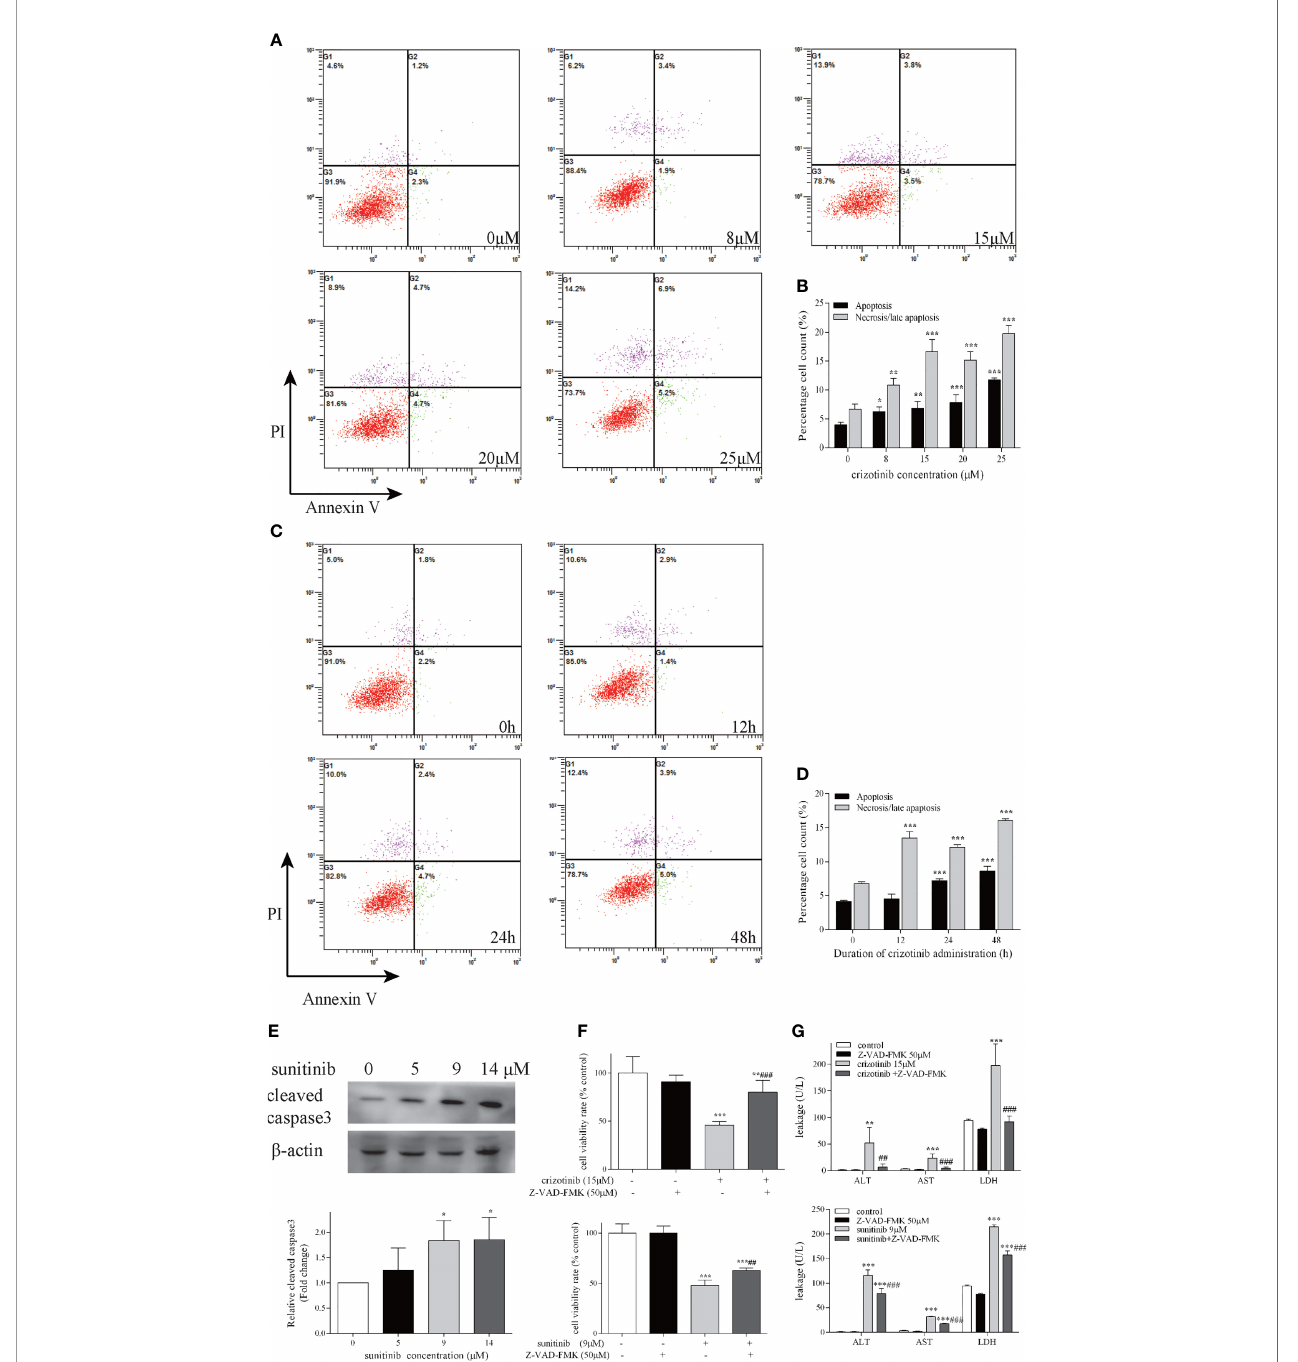
FIGURE 3 | Crizotinib and sunitinib induced apoptosis in HepG2 cells. Following treatment of cells with increasing doses of crizotinib for 24 h (A) and increasing administration time of crizotinib 15 µM (C) , cell apoptosis was measured by Annexin V − FITC/PI double staining assay. In the fl ow cytometry plot, live, early apoptotic, late apoptotic and necrotic cells were shown in the lower left, lower right, upper right and upper left quadrants, respectively. (B) Quanti fi cation of experiments shown in (A) . (D) Quanti fi cation of experiments shown in (C) . (E) Western blot analysis for the level of cleaved caspase 3 after sunitinib exposure for 24 h (n=3). (F) The cell survival rate for HepG2 cells after treatment with crizotinib or sunitinib with or without Z-VAD-FMK. Cell viability was measured by the MTT assay, and (G) The levels of ALT, AST, and LDH in the supernatant of HepG2 cells treated with crizotinib or sunitinib with or without Z-VAD-FMK (n=3). In these experiments, cells were pretreated with Z-VAD-FMK 50 m M for 24 h before crizotinib (15 m M) or sunitinib (9 m M) treatment. *P < 0.05, **P < 0.01 or ***P < 0.001 (the crizotinib or sunitinib alone vs. control). ## P < 0.01 ### P < 0.001 (the crizotinib or sunitinib alone vs. the crizotinib or sunitinib pretreated with Z-VAD-FMK). ALT, alanine aminotransferase; AST, aspartic acid transferase; LDH, lactate